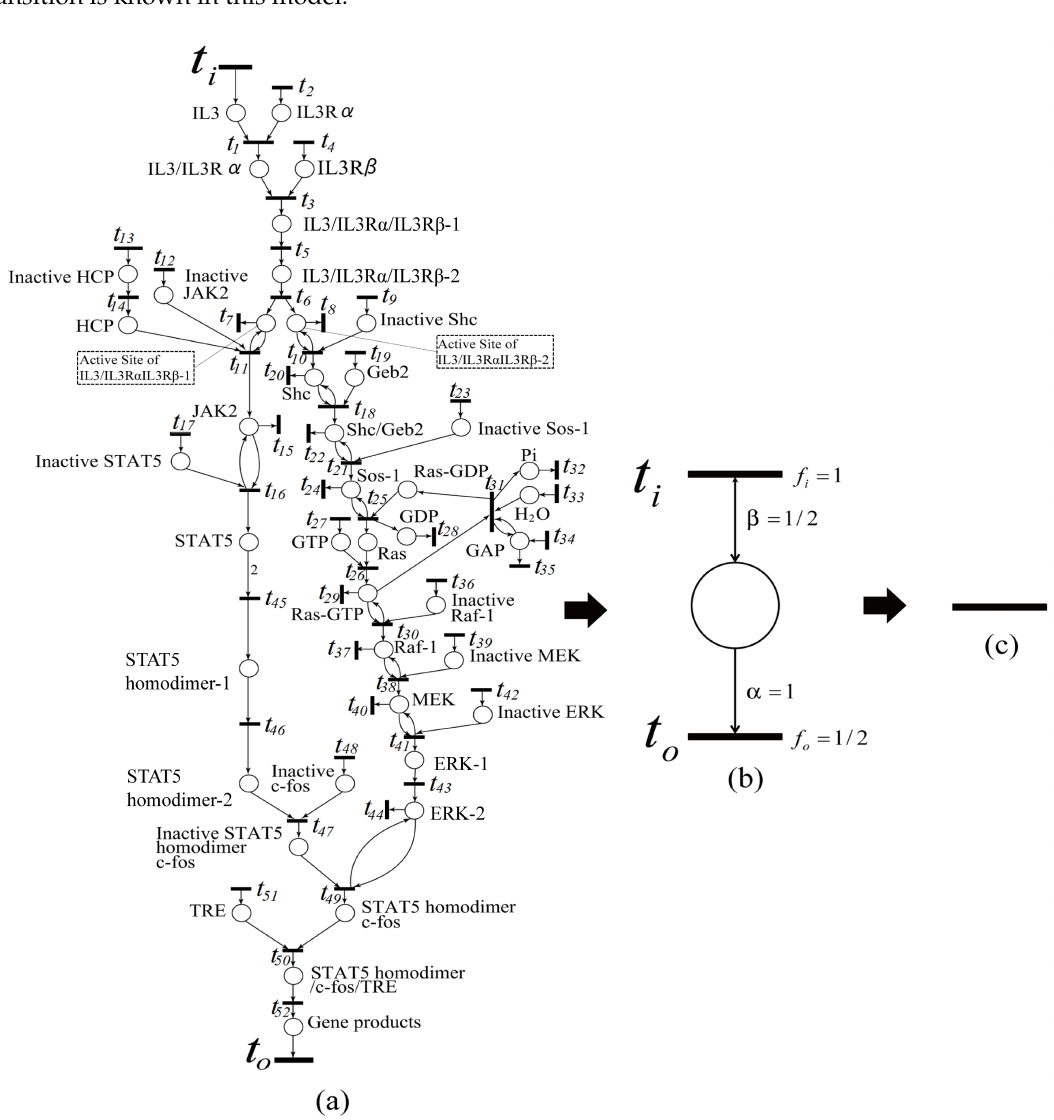
Figure 15. Shrinking processes of the IL-3 Petri net model. ( a ) Petri net model of IL-3; ( b ) intermediate shrunk net; ( c ) final shrunk